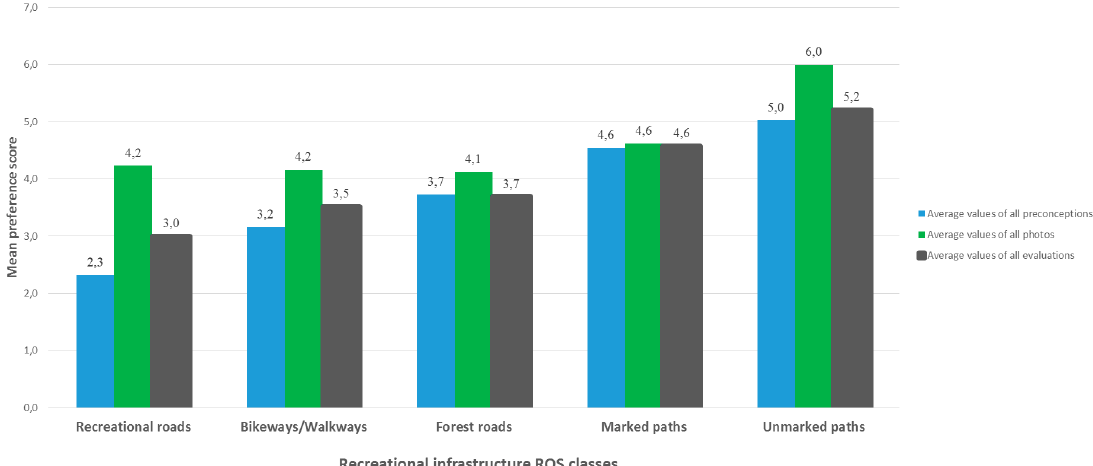
Figure 2. Mean preference score for 5 × 3 photos (green bars) and 5 × 7 verbal preconception (blue bars) based on 4671–5115 evaluation (1 to 7 Likert scale) within each ROS class. Black bars depict the sum of all evaluation of photos and preconceptions. All values and classes differ significantly ( p < 0.05, SE < 0.031 for all). See Table A1 for preference score details.